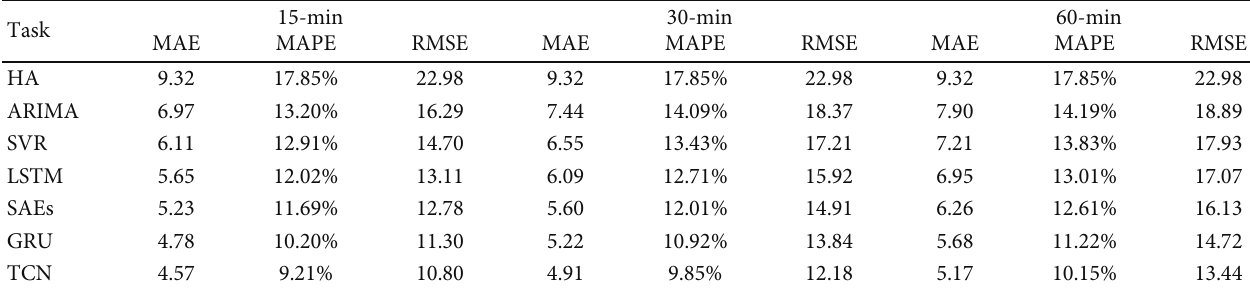
Table 2: Comparison of the performance of temporal prediction.